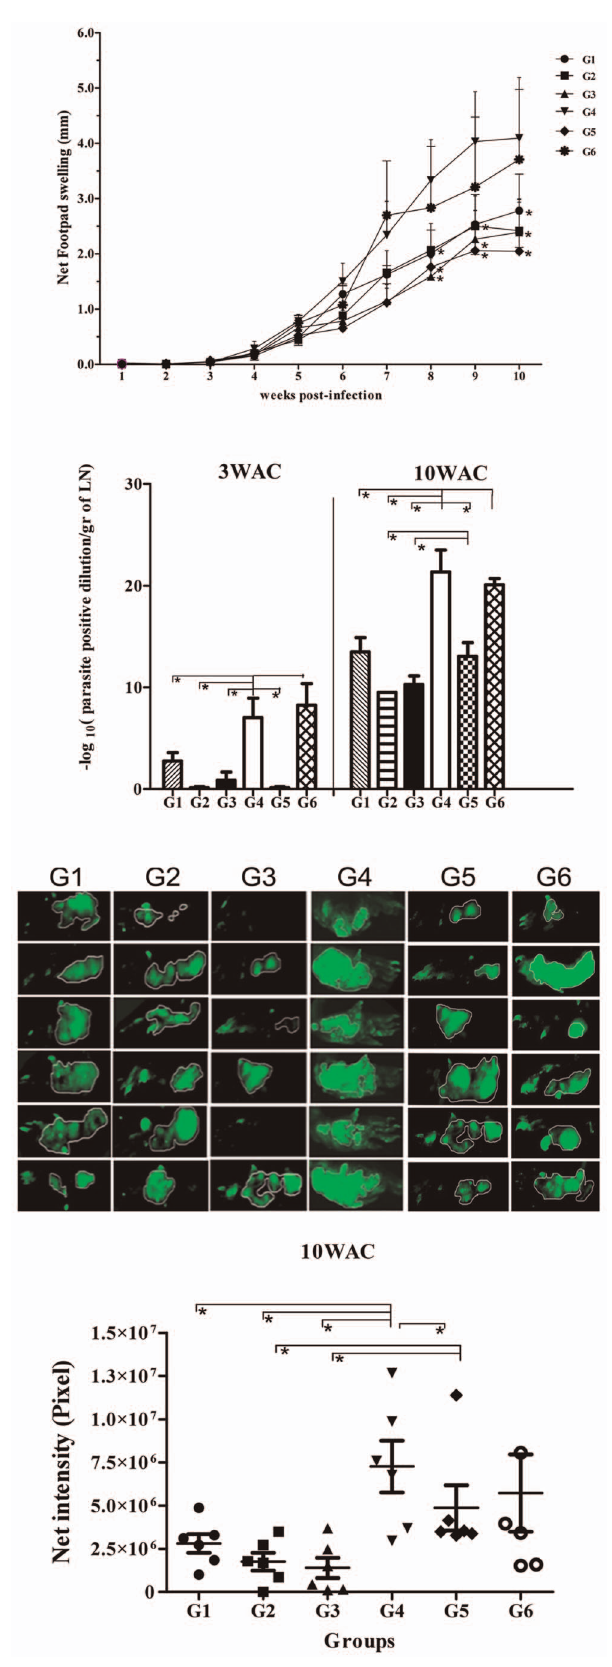
Figure 4. The course of infection with L.major GFP + in BALB/c mice vaccinated with different modalities. BALB/c mice were immunized in the right footpad with L. tarentolae CPA/CPB/EGFP (G1, rLive/rLive); primed with DNA PpSP15 and boosted with L. tarentolae CPA/CPB/EGFP and DNA PpSP15 (G2, DNA/rLive + DNA); primed and boosted with both L. tarentolae CPA/CPB/EGFP and DNA PpSP15 (G3, DNA + rLive/DNA + rLive); injected with PBS as control (G4), vaccination and boosting with VR1020-SP15 (G5, DNA/DNA); G6: vaccination and boosting with L. tarentolae EGFP + (G6, control Live/Live). All animals were challenged with stationary phase L. major (2 6 10 6 /mice) plus SGH (0.5 pair) in the left footpad except for G1 and G6, which received only L. major . A) The footpad swelling represents the Mean 6 SD of 12 mice per group; Asterisks indicate statistical significance (Mann Whitney U test, * p , 0.05) compared to the control group (G4). B) Parasite burden per lymph node in all groups at 3 and 10 weeks post challenge (WAC). Each data point represents the Mean 6 SD of 4 lymph nodes per group; statistics were carried out by ANOVA. C) Photographs of mouse footpads infected with fluorescent L. major for G1–G6. D) Net intensity by fluorescence imaging at 10WAC; statistical differences was determined by the Mann Whitney U test ( p , 0.05 denoted as *). Values of two independent experiments are shown in the